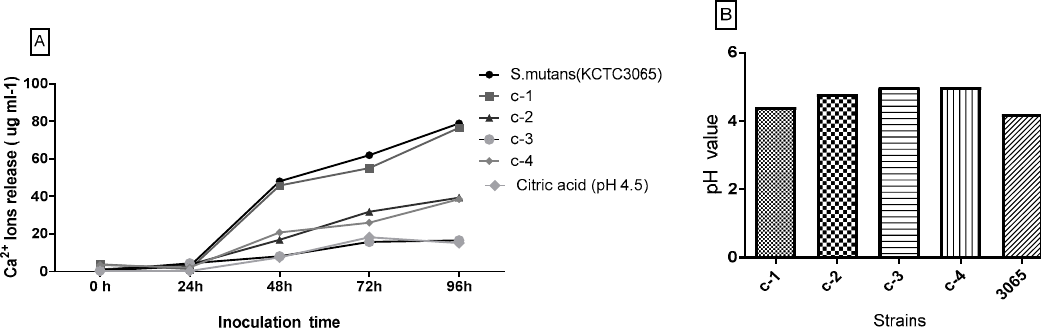
Figure 5. Calcium release from the tooth surface and acidification of cultures caused by isolated bacterial and reference strains. C-1: Streptococcus salivarius ; C-2: Streptococcus anginosus ; C-3: Leuconostoc mesenteroides ; C-4: Lactobacillus sakei . Each tooth was repeatedly disinfected and used alternately after each experiment, the data of Ca 2+ ions release ( A ) and the terminal pH ( B ) of each culture were expressed as average. The teeth were immersed in the medium (pH 4.5) without inoculation as the negative control.